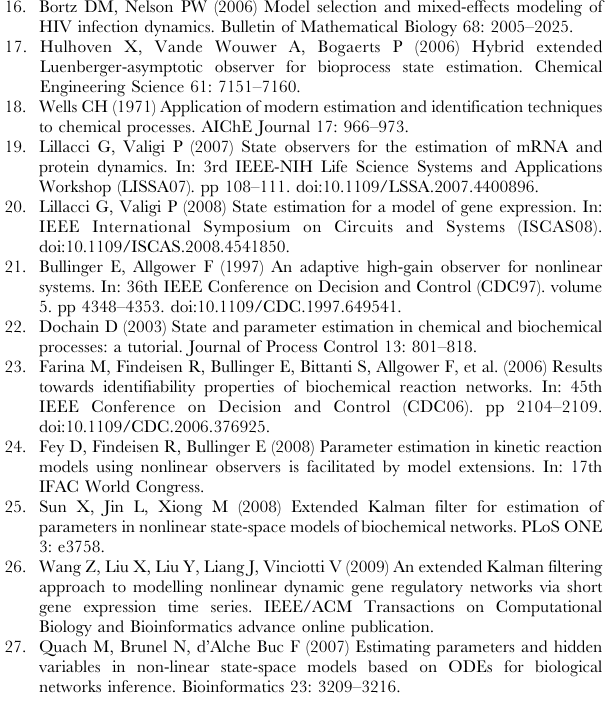
Figure S1 Estimation of 18 parameters in the repressilator model (measurement m 3 ). The data points (green squares) are obtained by evaluating the true model solution (red dashed curve) at the chosen time points, and then adding white Gaussian noise. The blue solid line shows the reconstructed solution corresponding to the estimated parameters. Found at: doi:10.1371/journal.pcbi.1000696.s002 (0.42 MB